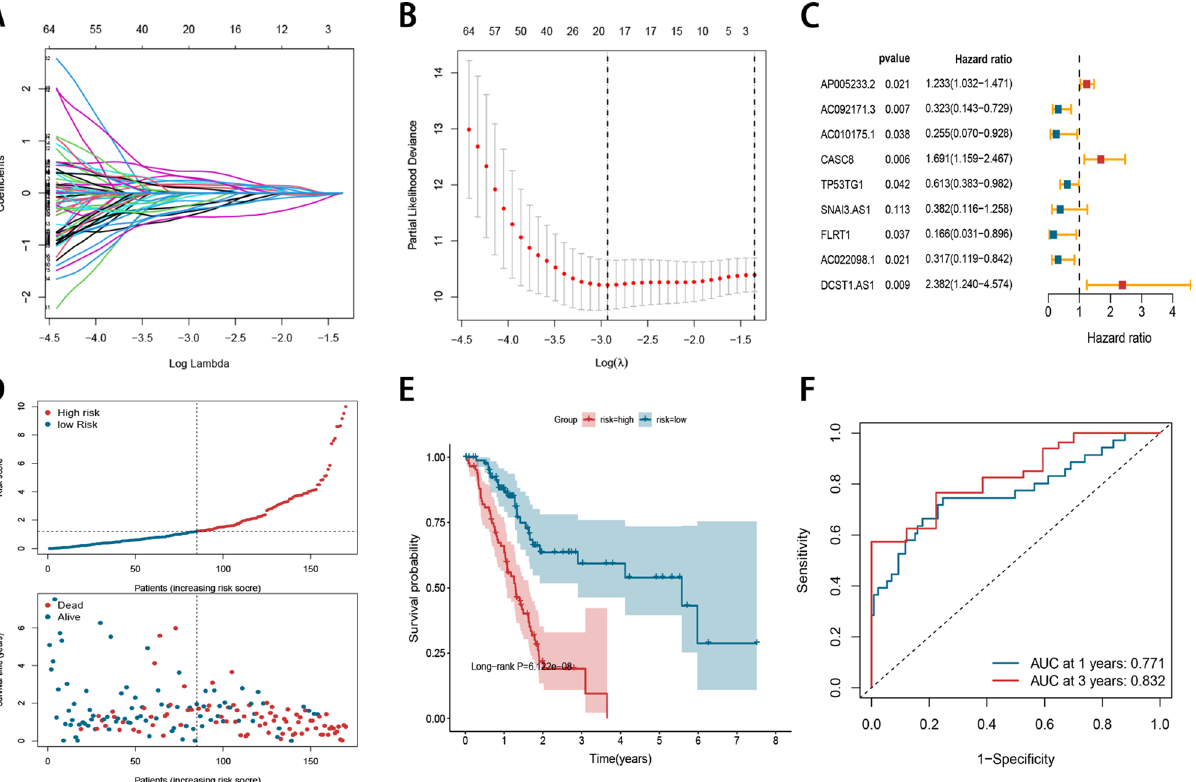
Figure 1. Construction of m6A-related lncRNA signature in PDAC patients. ( A , B ) The LASSO regression analysis and partial likelihood deviance of the 19 m6A-related lncRNAs. ( C ) Forrest plot showed that a total of 9 m6A-related lncRNAs were identified as prognosis related by multivariate cox analysis. ( D ) The distribution of the risk scores and patient living status. ( E ) Kaplan–Meier survival estimates of OS according to the signature. ( F )The 1- and 3-year ROC curves of the signature in predicting OS of PDAC